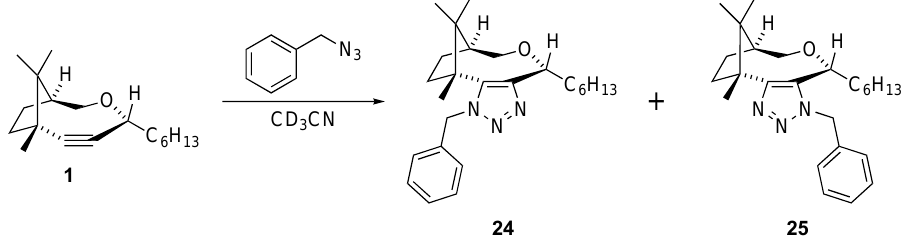
( c ) Figure 2. ( a ) Calculated angle-strain in cyclooctyne 1 ; ( b ) 3D ball-and-stick molecular model of minimized ( R )- 1 ; ( c ) 3D ball-and-stick molecular model of minimized ( R )- 15 (hydrogen atoms are omitted for clarity). Furthermore, the stability of compound 1 , which has an ( R ) configuration at the chiral center (marked with an arrow in Figure 2a) was 1.51 kcal/mol higher than its analog with ( S ) configuration. In addition, calculations performed for the cobalt-complex precursor 15 , with B3LYP/def2SVP optimization, revealed that such difference in stability increased to 7.62 kcal/mol. Thus, the product with (R) configuration is favored enthalpically, as is the formation of the cobalt complex precursor. Clearly, the angular stress release as a consequence of complexation favors the Nicholas reaction, being that its selectivity is controlled by the electrostatic and steric effects generated in the new scenario. Finally, a simple preliminary test was carried out in order to evaluate the potential use of these compounds in the strain-promoted azide-alkyne cycloaddition (SPAAC)